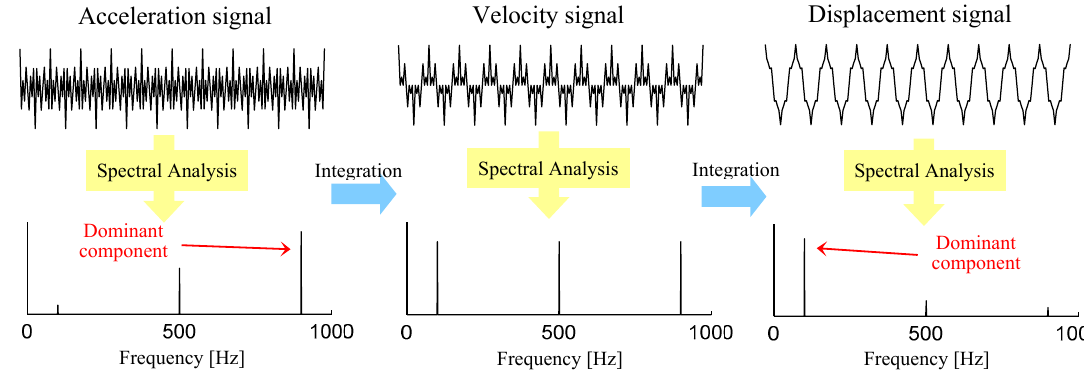
Figure 9. Enhancement of low frequency components by the integration operator. Table 1. The amplitude of each sinusoidal component in the three types of signals.